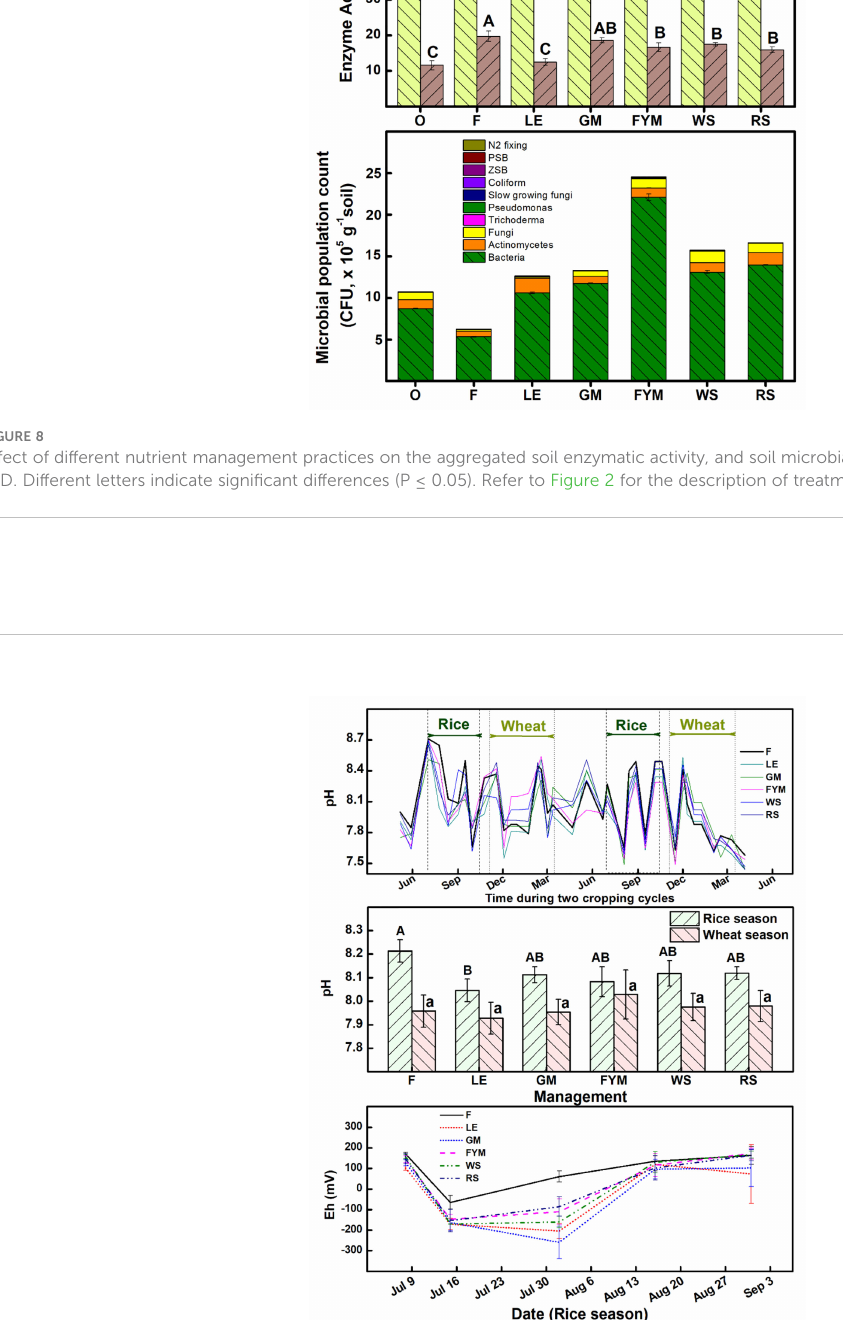
FIGURE 9 Effect of different nutrient management practices on soil pH and redox potential (Eh) during the rice-wheat seasons. Error bars denote ± 1SD. Different letters indicate signi fi cant differences (P ≤ 0.05). Refer to Figure 2 for the description of